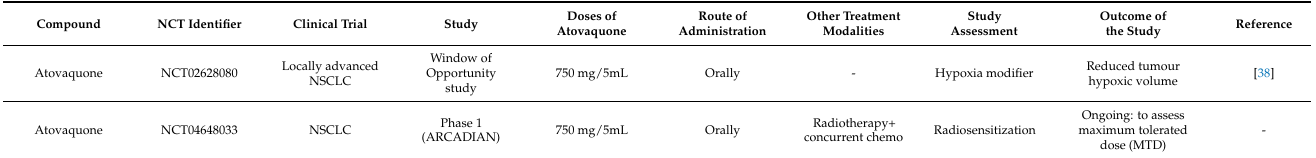
Table 2. Clinical trials of Atovaquone in other